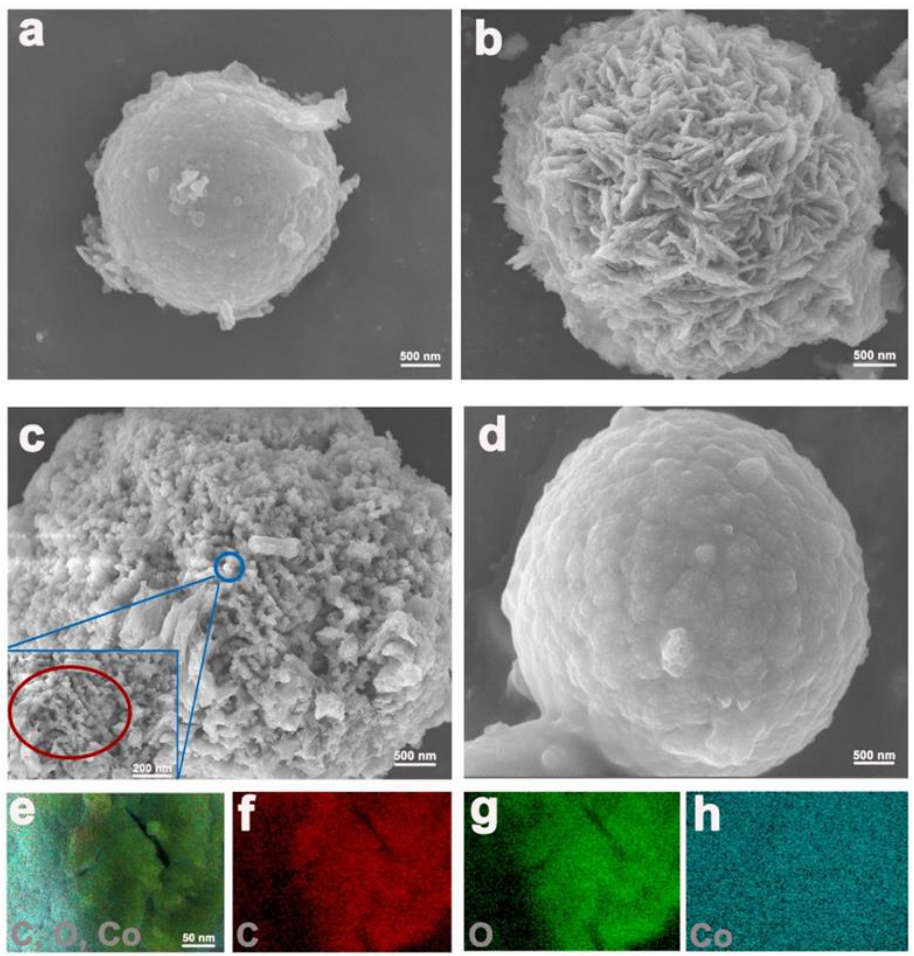
Figure 3. ( a – d ) SEM images of Co-BTC@GO 0, 1, 2, and 4; ( e – h ) EDS mapping of Co-BTC@GO.